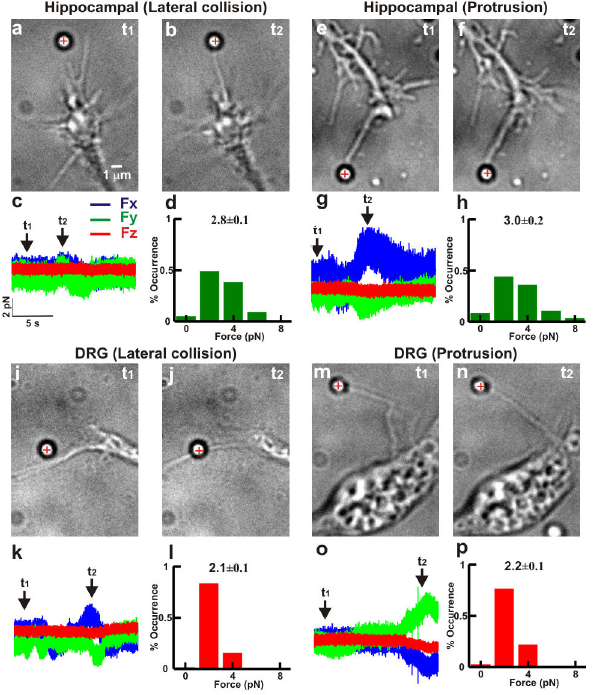
Figure 3. Lateral collision and protrusion of filopodia. ( a – b ) Lateral collision between a filopodium from hippocampal neuron and a trapped bead. The cross indicates the bead’s equilibrium position inside the optical trap. ( c ) F during the lateral collision shown in ( a – b ). ( d ) Histogram of force measured during lateral collision in hippocampal neurons (n=41). ( e – f ) Collision between a protruding filopodium from hippocampal neuron and a trapped bead. ( g ) F during the filopodial protrusion shown in (e– f ). ( h ) Histogram of forces measured during protrusions (n=24). ( i – l ) As in ( a – d ) for a filopodium from a DRG neuron (n=39). ( m – p ) As in ( e – h ) for a protruding filopodium from a DRG neuron (n=22). All values reported in d, h, l and p are given as mean ± SE.